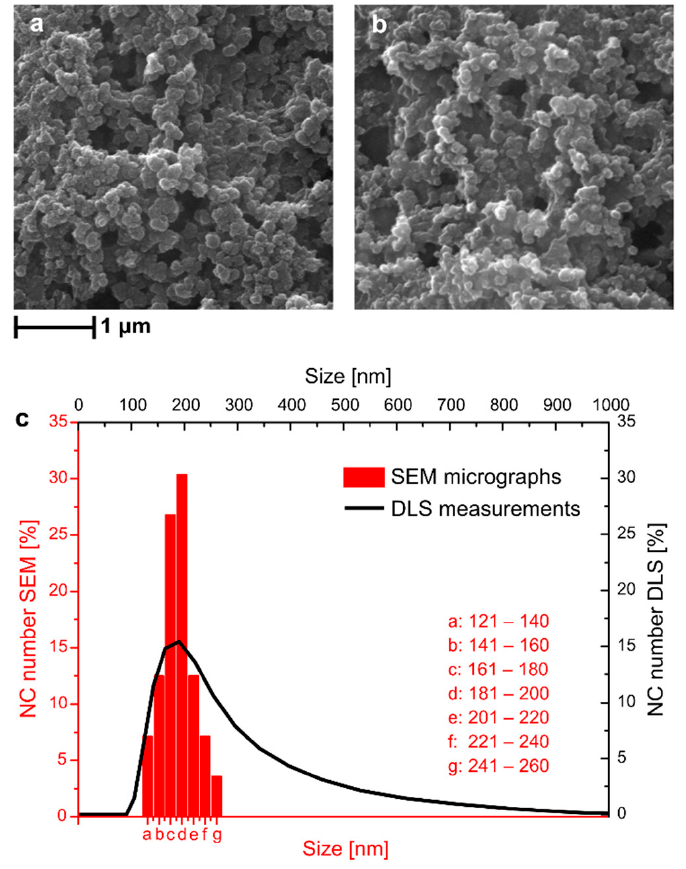
Figure 1. SEM micrographs of NC-TEO before ( a ) and after ( b ) treatment with liquid nitrogen and comparison between DLS and ImageJ analyses of SEM micrographs ( c ).